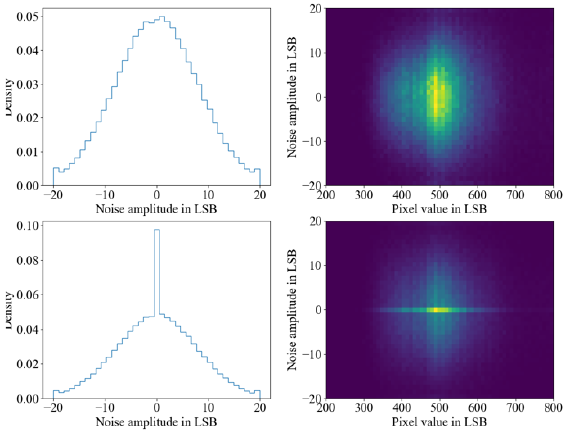
Figure 3 Noise distribution used data augmentation. First row is our data augmentation where the noise variance depends on the pixel LSB value. Second row is a white classical gaussian noise distribution. The problem is far more complex with our distribution and according to sensor models